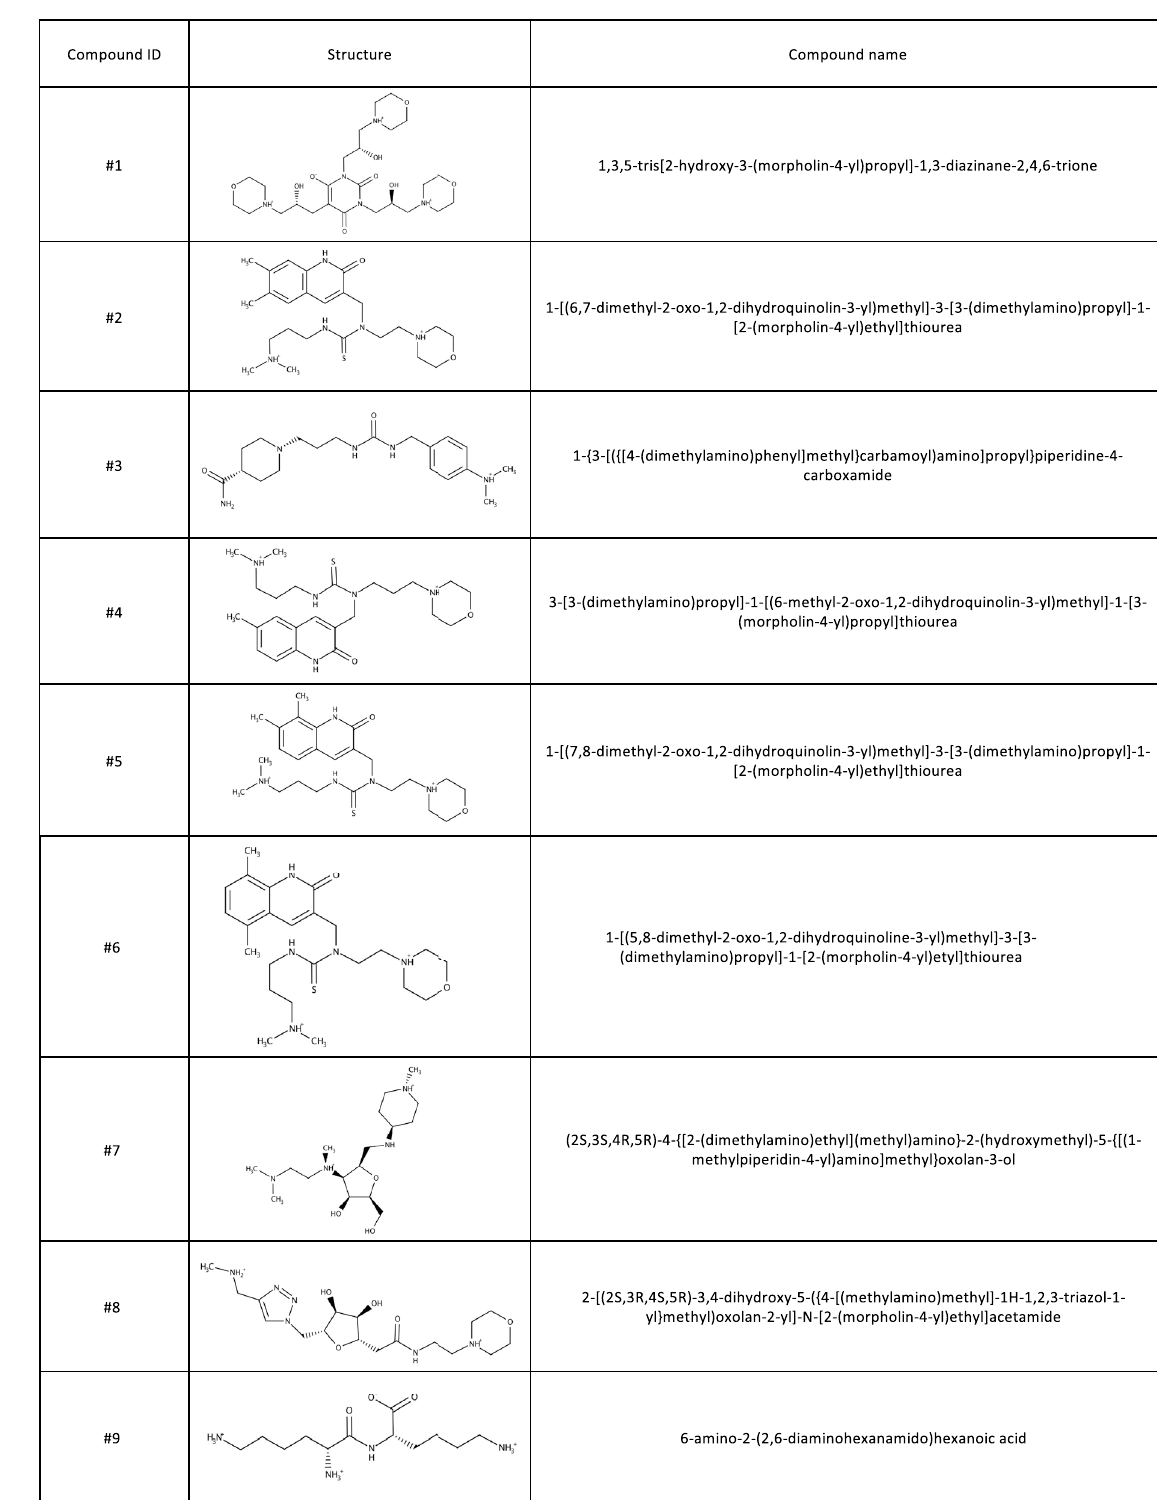
Figure 5. Structures of nine compounds selected by virtual screening. ( a ) The structures and names of compounds #1–#9 identified from docking simulations between molecules identified in pharmacophore virtual screen and the Val78, Asp94, Ser112, and Glu167 residues in the catalytic pocket of the A-subunit. ( b ) Structural view of binding between the Stx2a A-subunit and each compound. Structure images were created using PyMOL ver. 2.3.4, (https:// pymol.